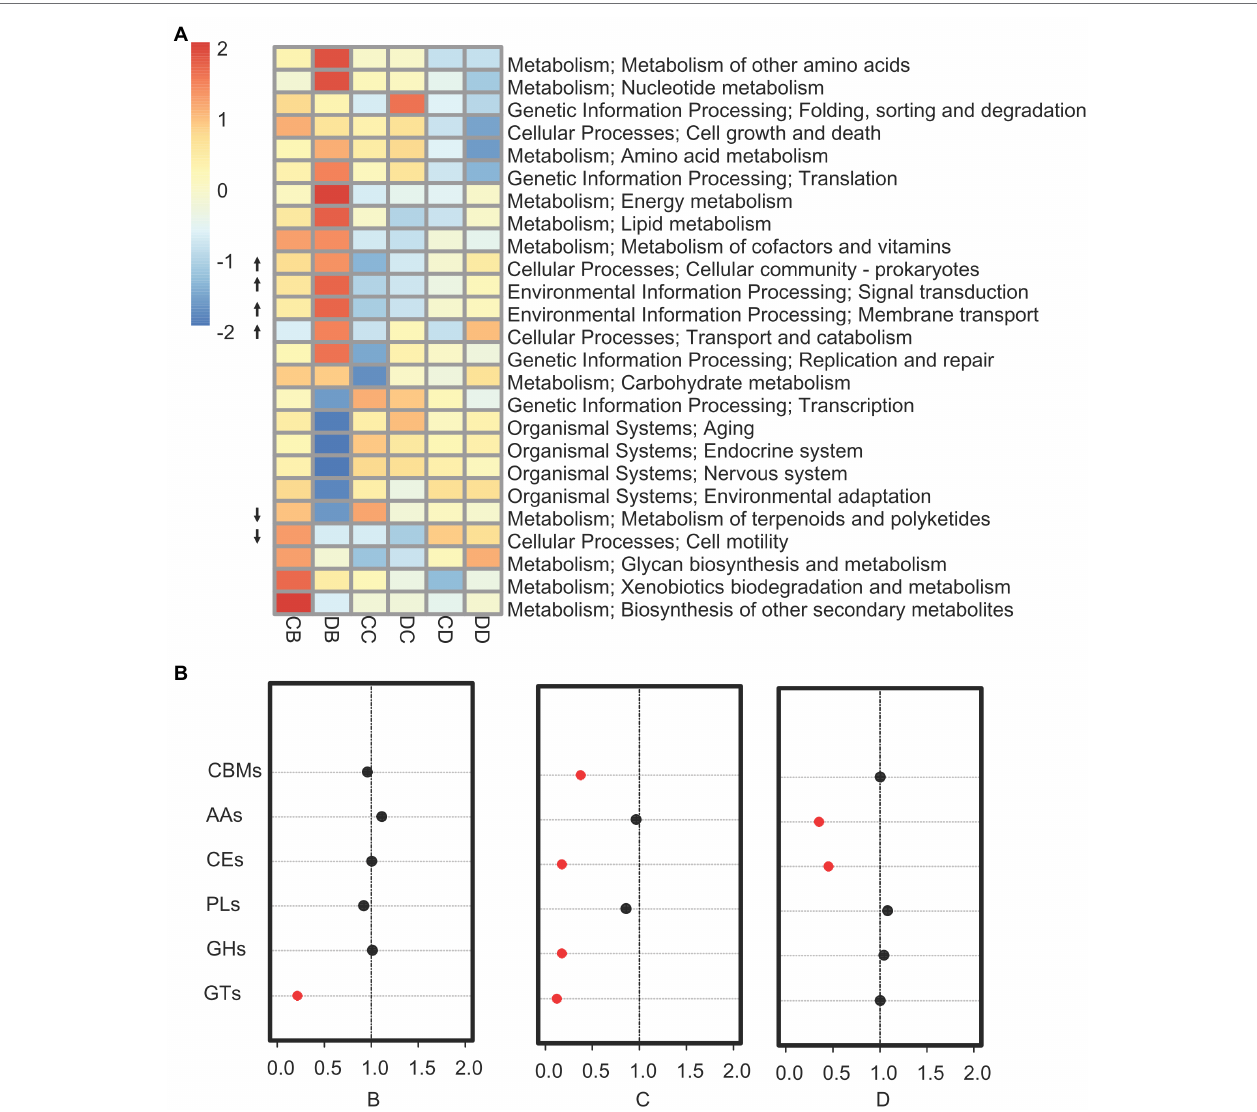
FIGURE 3 | Drought impacts on the rhizosphere microbiome gene pool. (A) Kyoto Encyclopedia of Genes and Genomes enrichment analysis for all genes showing enrichment under drought for rhizosphere microbiomes. Categories significantly enriched are indicated ( p ≤ 0.05; Fisher’s exact test). The up (down) arrow indicates categories for which there are more (less) genes in the drought samples than in the control. (B) Enrichment analysis for all enzymes that degrade, modify, or create glycosidic bonds annotated in the CAZy database. The red circles indicate categories for which the enrichment had a value of p < 0.05 in a Fisher’s exact test. The values on the x -axis indicate the fold enrichment ratio of annotated CAZy genes from samples B–D (drought treatment/control). CBMs, carbohydrate-binding modules; AAs, auxiliary activities; CEs, carbohydrate esterases; PLs, polysaccharide lyases; GHs, glycoside hydrolases; and GTs,